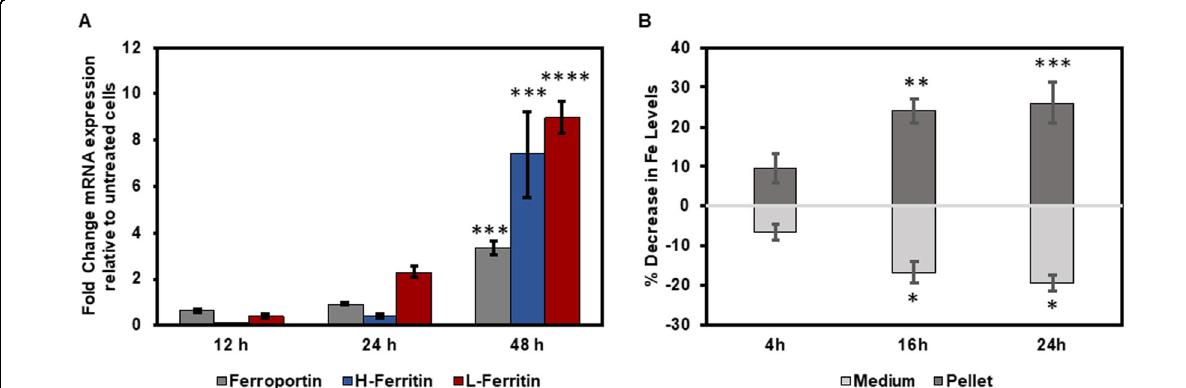
Fig. 5 Quanti fi cation of mRNA expression and iron levels of RAW264.7 in the presence of AfFtnAA. A mRNA expression levels of ferroportin, H-ferritin and L-ferritin in macrophages in the presence of 200 nM AfFtnAA for 12, 24 and 48 h. The mRNA expression levels were calculated relative to control samples without AfFtnAA treatment. B Decreases in the intracellular (pellet) Fe levels and medium measured at 4, 16 and 24 h. The change was calculated in reference to cells and medium at the 0 h timepoint ( n = 3) (* p < 0.05, ** p < 0.01, *** p < 0.005, **** p < 0.001). Signi fi cance values are represented with respect to the untreated control samples for ( A ) and with respect to the 0 h timepoint for ( B ).